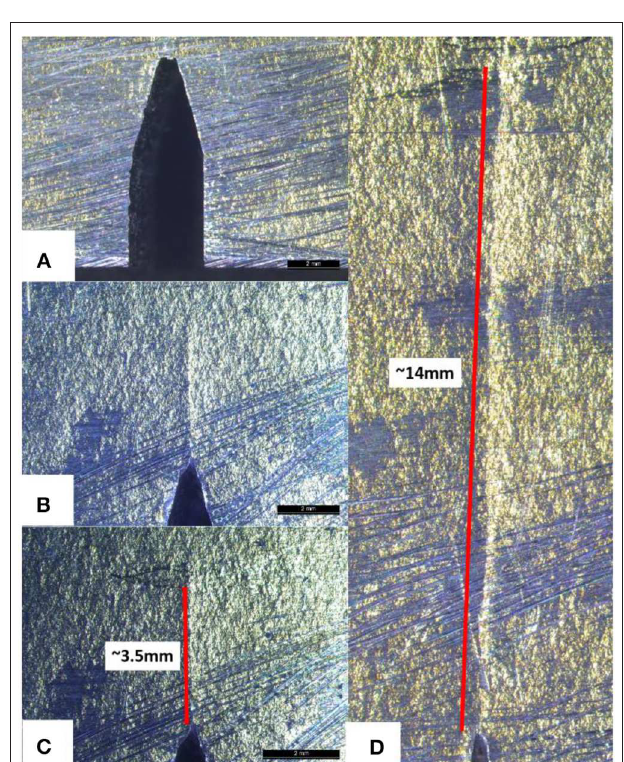
FIGURE 5 | Aluminum fatigue sample with experimental layout (Fierro and Meo, 2019).